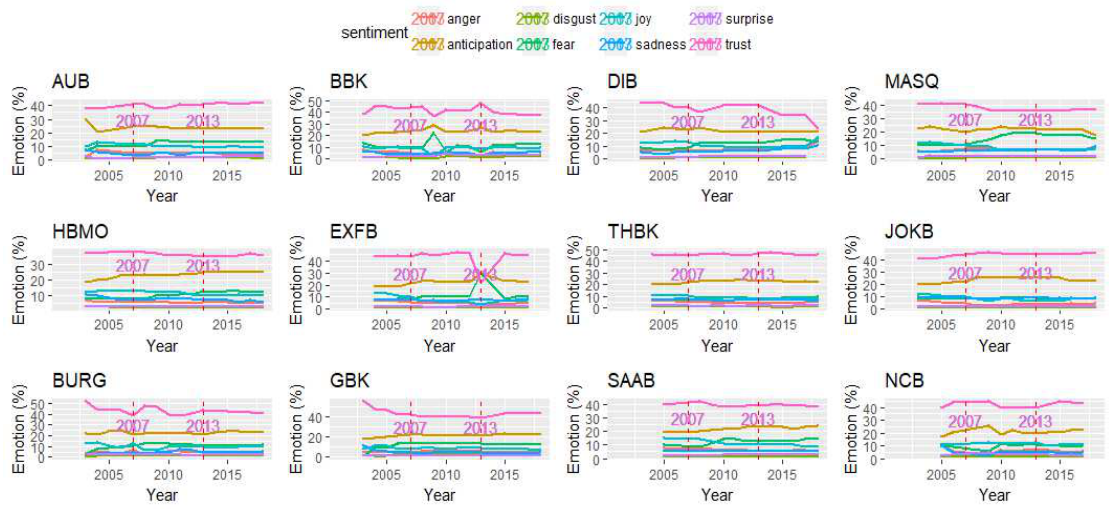
Figure 3. The trend of the eight emotional categories in banks’ annual reports (from 2002 to